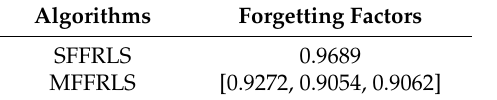
Table 3. Forgetting factors optimized by PSO.